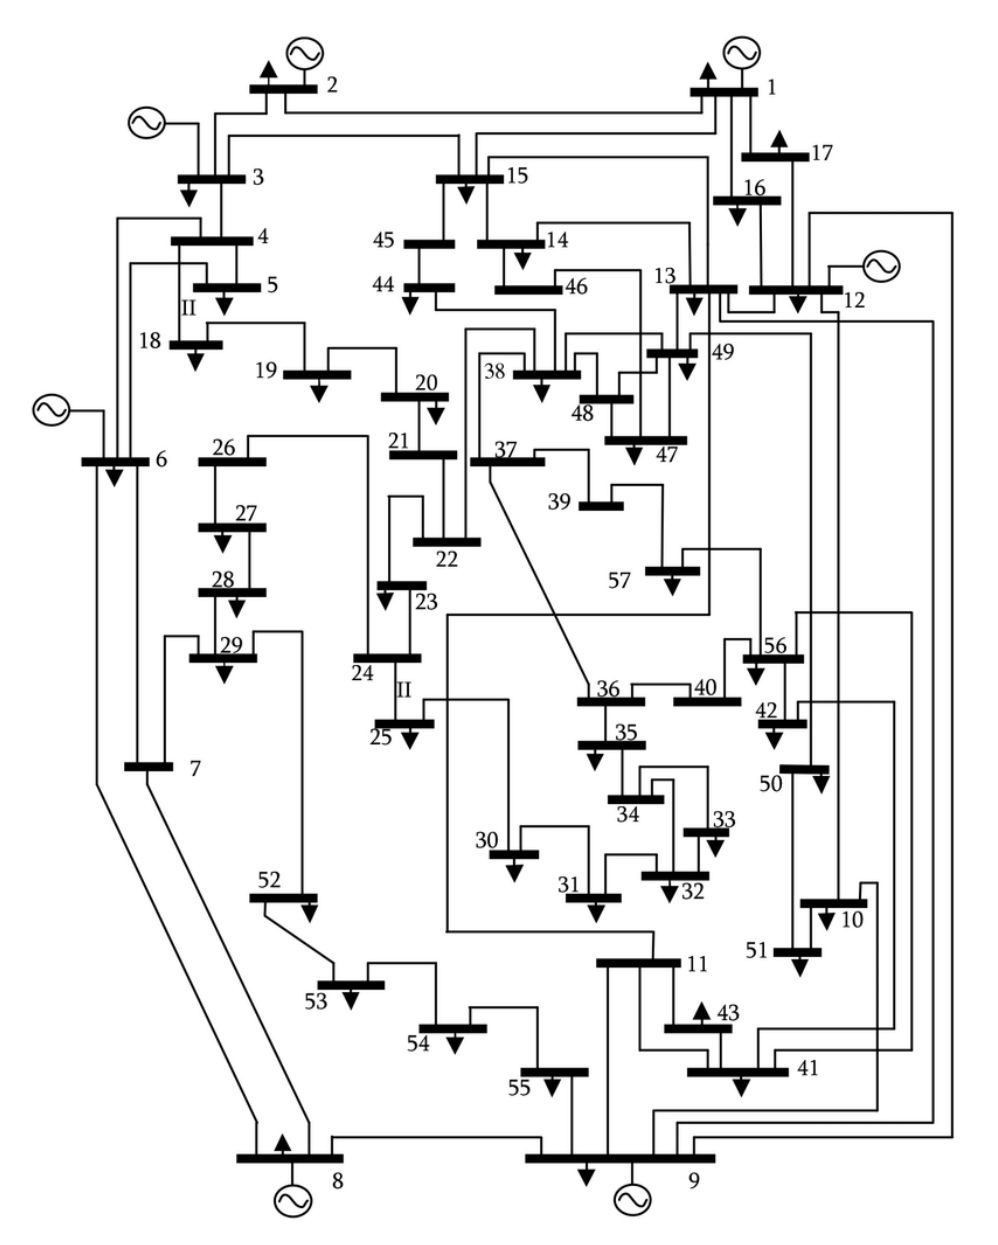
Figure 5. 57 buses